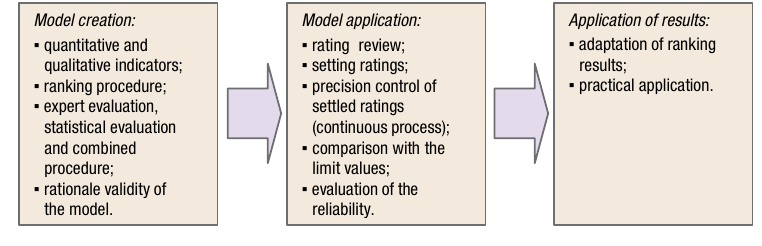
Fig. 2. The process of model